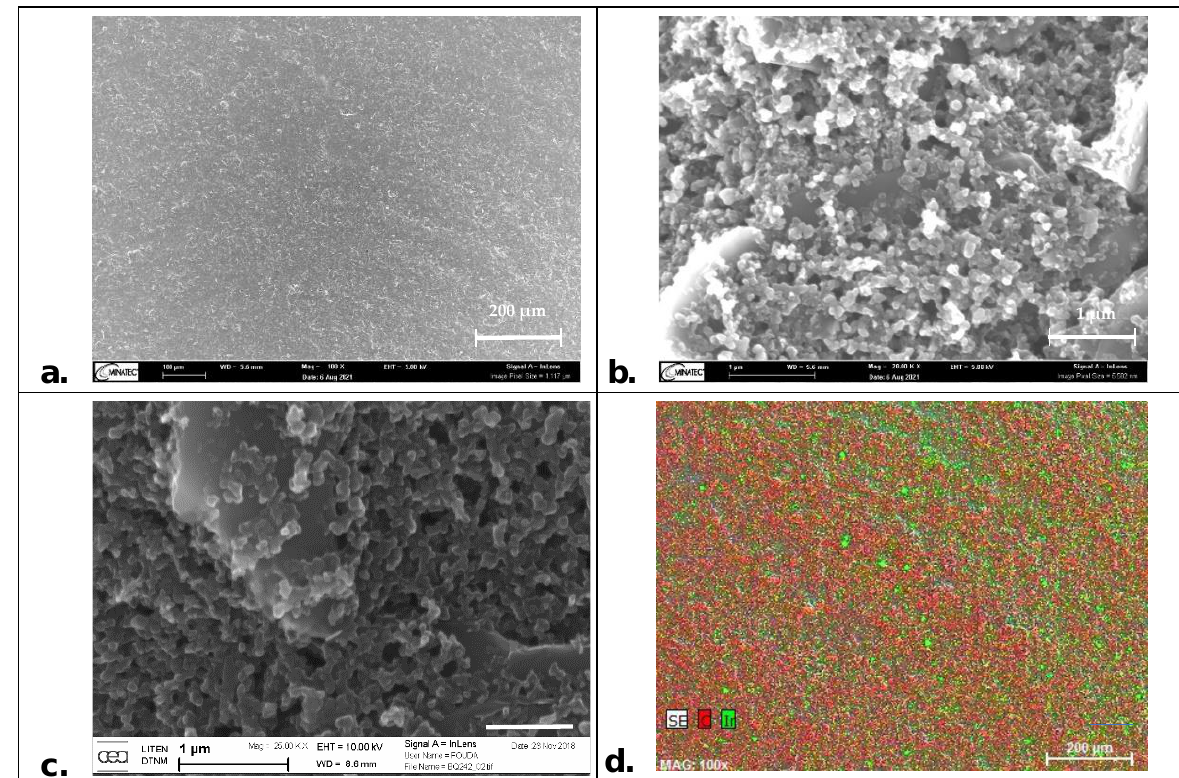
Figure 4. Surface morphology of carbon-based electrodes. Characterization by scanning electron microscopy (SEM) at 5 kV of the modified-carbon electrode (carbon BQ242 + IrOx 2 wt% electrode) at different magnification level of ( a ) 100× and ( b ) 20k× and ( c ) the unmodified carbon electrode at 25k×. ( d ) Electron dispersive X-ray (EDX) mapping analysis of: carbon (in red) and iridium (in green) for the modified-carbon electrode.